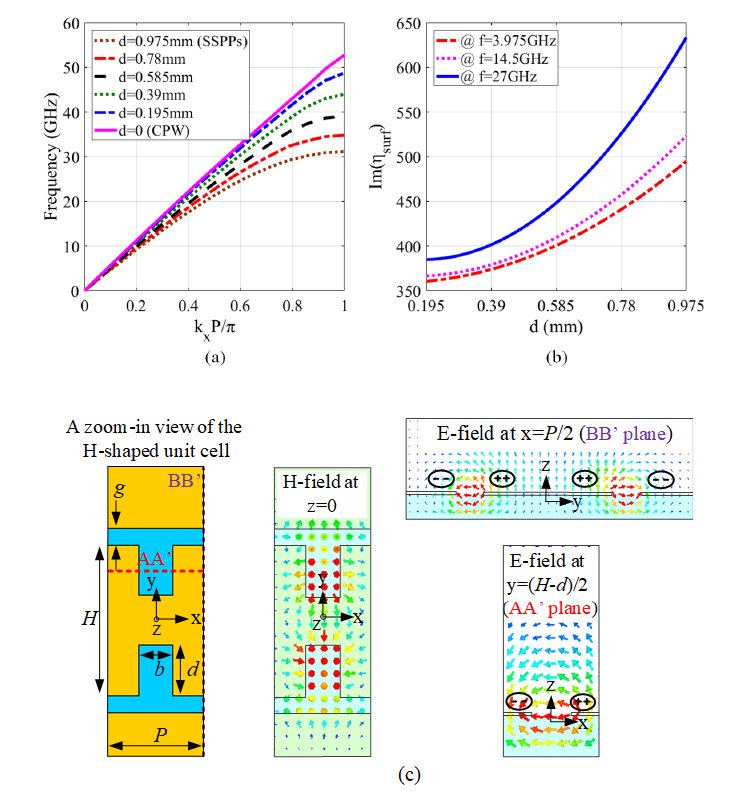
Figure 2. ( a ) Effect of the groove depth on dispersion curve of the cell. ( b ) The surface impedance of the cell by groove depth change in different frequencies. ( c ) The distribution of E-field & H-field at three orthogonal planes (E-field at A-A’, and B-B’, H-field at z =